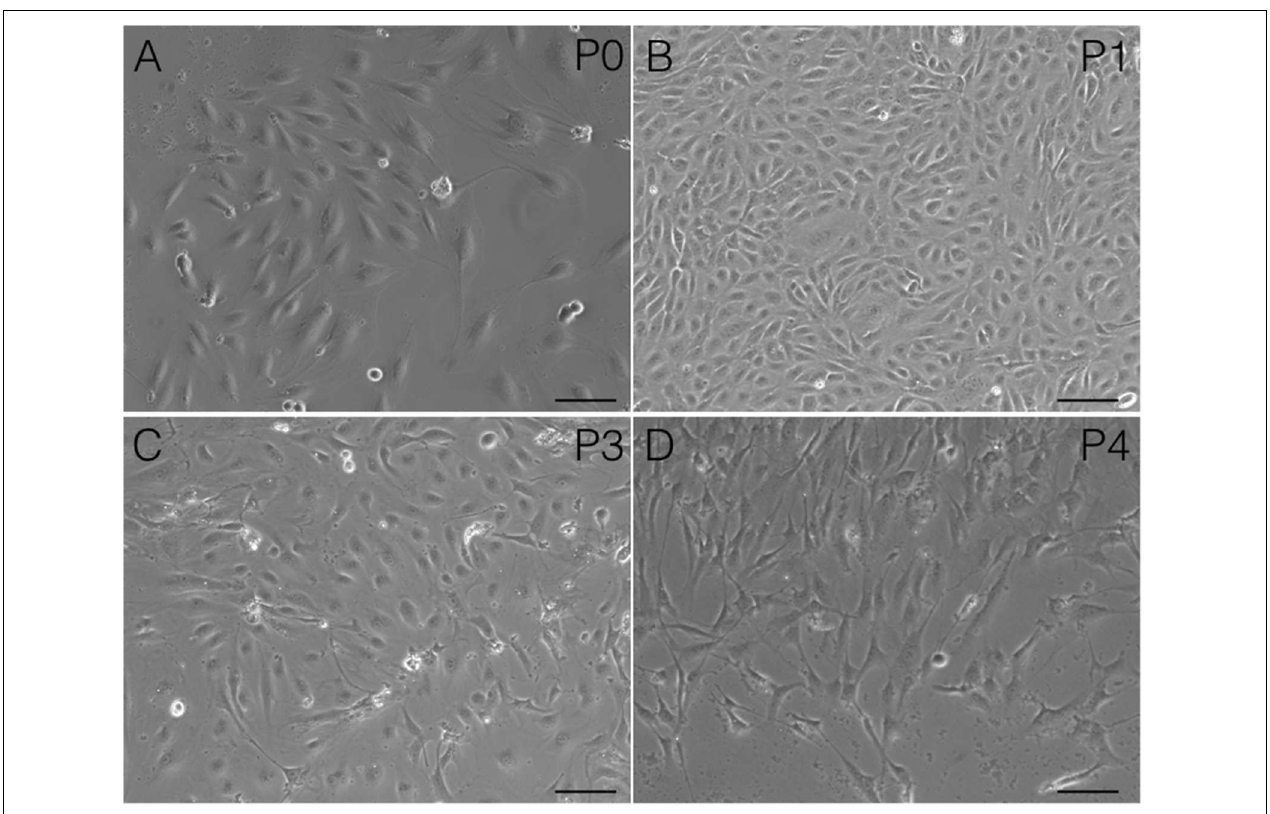
FIGURE 9 | Changes in cAVM-EC morphology when isolated and passaged. (A) morphology in P0; (B) morphology in P1; (C) morphology in P2; (D) morphology in P3. Scale bar = 50 µ